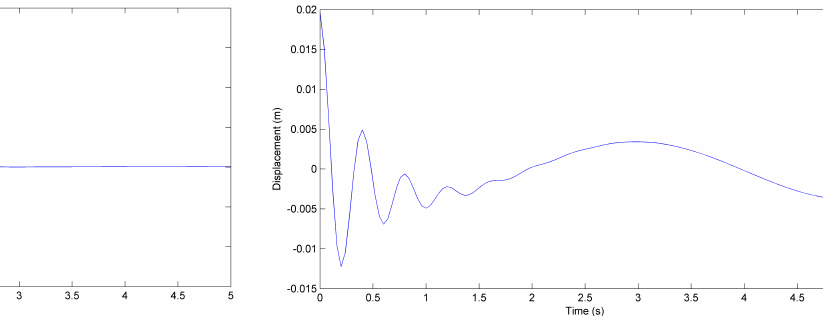
Figure 6: Free vibration.